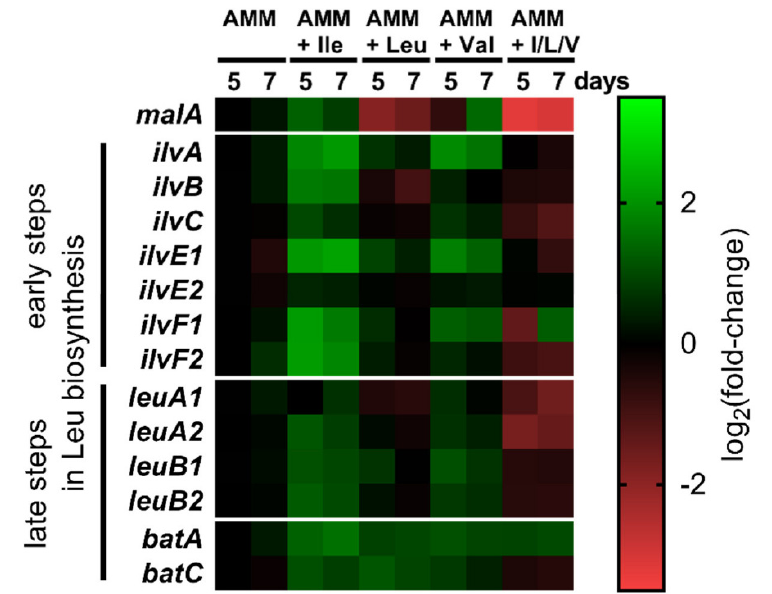
Figure 4. Heatmap of the expression profiles of the M. alpina BCAA and malpinin biosynthesis pathways based on qRT-PCR data. For details on BCAA genes and expression raw data, refer to Tables 1, S6, and S7. malA , malpinin synthetase gene. AMM, Aspergillus Minimal Medium, without or supplemented with 10 mM BCAAs; + I/L/V, + Ile + Leu + Val (10 mM each).